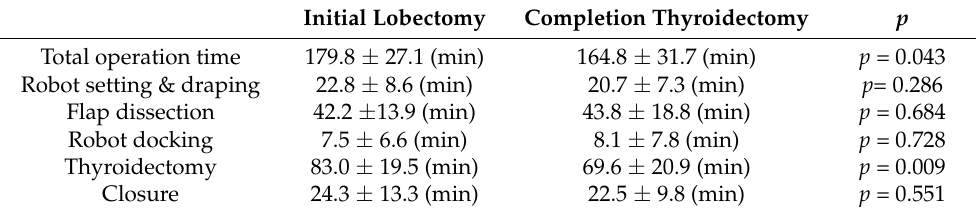
Table 3. Detailed analysis of operation time for each step of BABA robotic thyroidectomy.